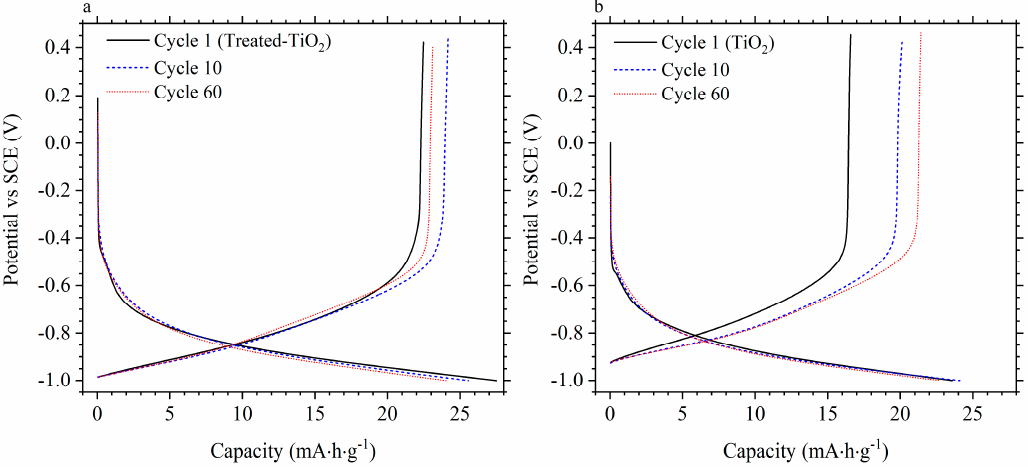
Figure 6. Voltage profile of the treated-TiO 2 ( a ) and TiO 2 ( b ) electrode during cycling at 1 A/g in 1